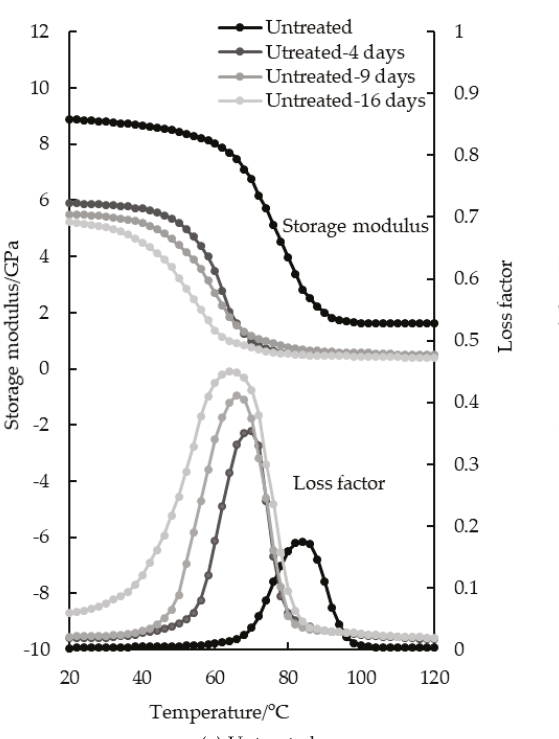
Figure 2. Relative water uptake of FFRP weight increment percentage of FFRP.